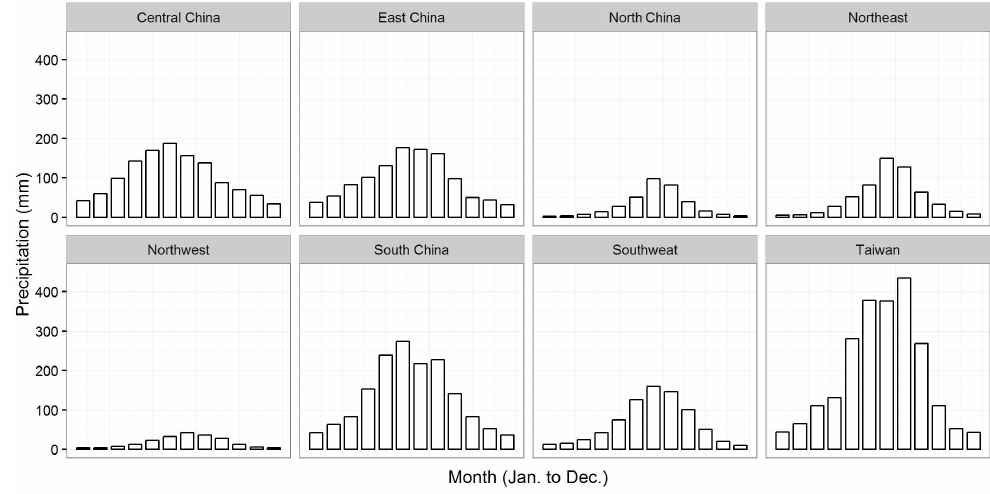
Figure 2. Monthly mean precipitation for the period 1961 to 2014 in eight regions in China: central China, east China, north China, northeast, northwest, south China, southwest, and Taiwan.